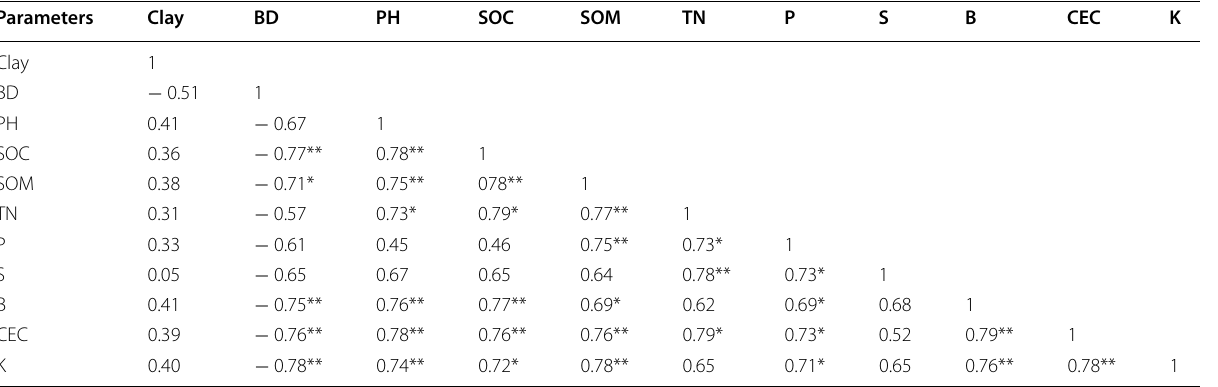
*Significant at p <